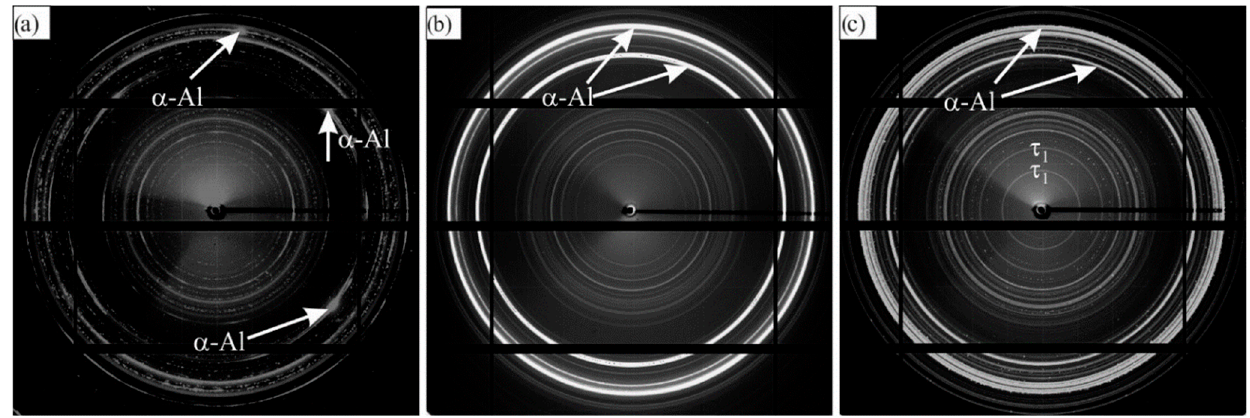
Figure 5. 2D-XRD images. ( a ) As-cast, ( b ) sample FSP95 in the stir zone, and ( c ) sample FSP950 in the stir zone (taken close to the area NZ in Figure 2).